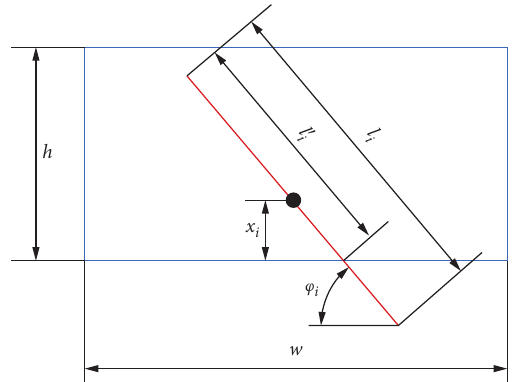
Figure 1: Intersection relationship between a trace with one end censored and the sampling window.